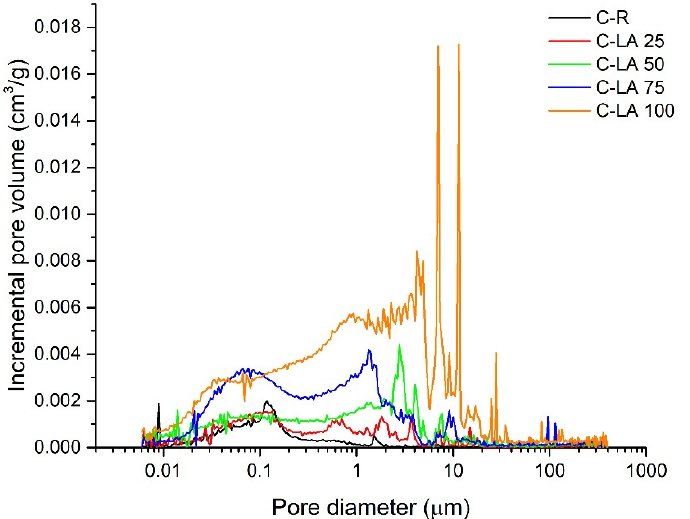
Figure 6. Pore size distribution-cumulative curves measured for control (C-R) and LA dosed sam- ples (C-LA 25–100).